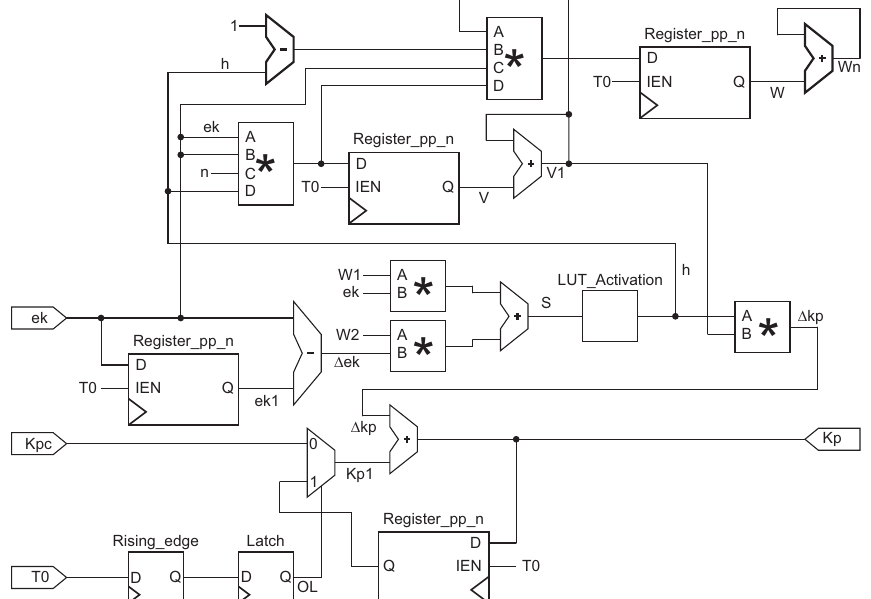
Figure 14. NNET module, neuro tuning variable for k p . The symbol * in this figure represents a multiplier